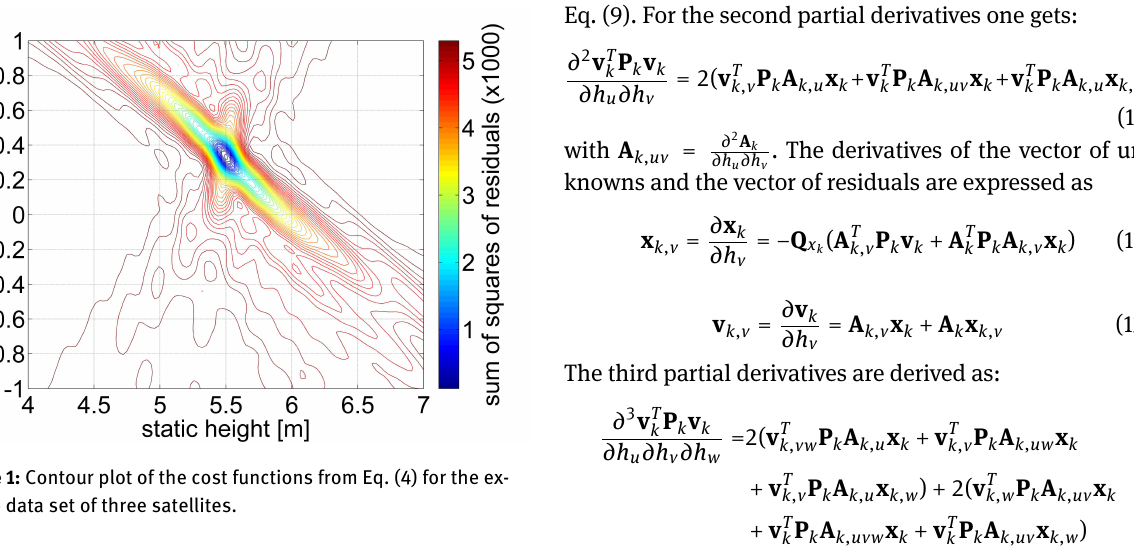
Figure 1 can be interpreted as a contour plot of a two- dimensional periodogram. A global optimization using a two-dimensional LSP to find the minimum with a resolu- tion quality of 1 cm for h and 1 cm/h for h needs an in- 0 1 crement of 0.5 cm and 0.5 cm/h resp. for the variation of the parameters. Hence, more than 240000 computations of Eq. (4) are needed for this simple case. For a more so- phisticatedglobal optimization basedon